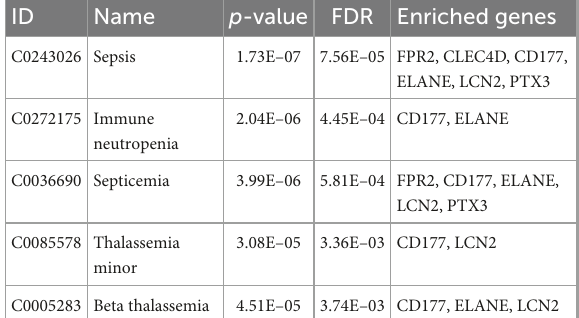
TABLE 3 The top five diseases enriched by hub